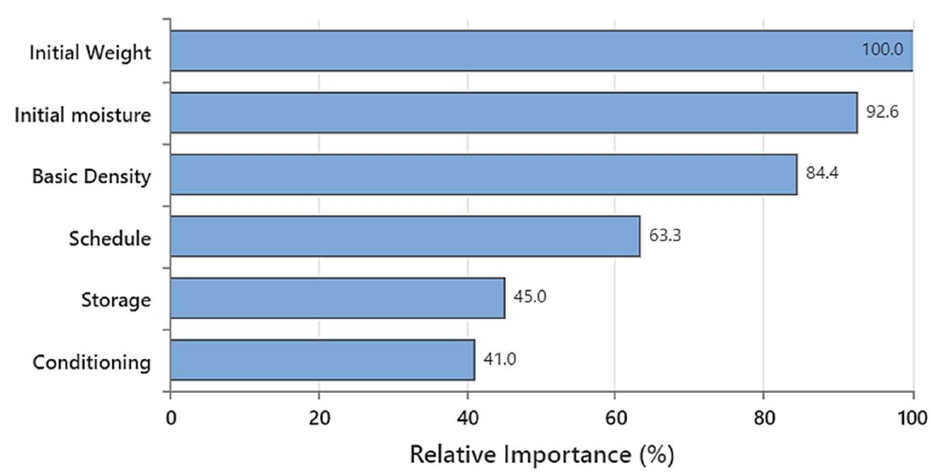
Figure 8. The relative importance of the inputs used to train the random forest approach for the M f predictive model.